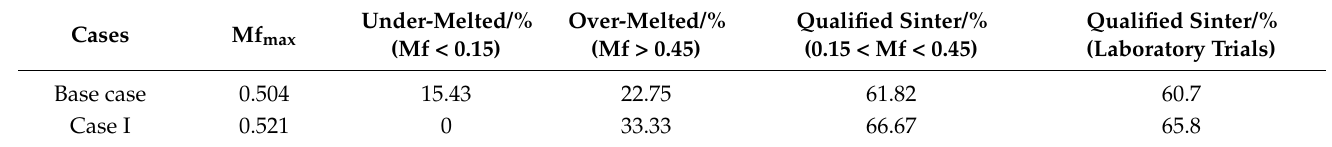
Table 5. Analysis of the Mf for the two technologies.